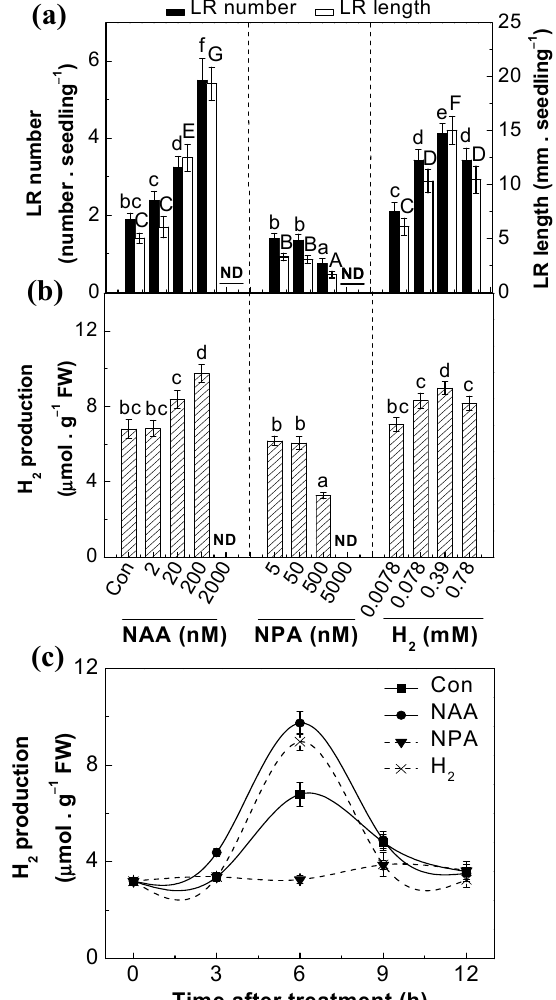
Figure 1. Effects of 1-naphthylacetic acid (NAA), N -1-naphthylphthalamic acid (NPA), and H 2 on lateral root formation and H 2 release. 3-day-old tomato seedlings were incubated with solutions containing various concentrations of NAA, NPA, and H 2 . ( a ) The number of emerged lateral roots (LRs) (>1 mm) per seedling and LR length were calculated after 3-day of treatments ( n = 60); ( b ) The H 2 production in roots was detected after 6-h treatment ( n = 5); ( c ) Time-course of H 2 production in response to 200 nM NAA, 500 nM NPA, and 0.39 mM H 2 ( n = 5). Distilled water was used for the control (Con) treatment. Data are the means ± SE of three independent experiments with at least three replicates for each. Within each set of experiments, bars denoted by the same letter did not differ significantly at the p < 0.05 level according to Duncan’s multiple range test.